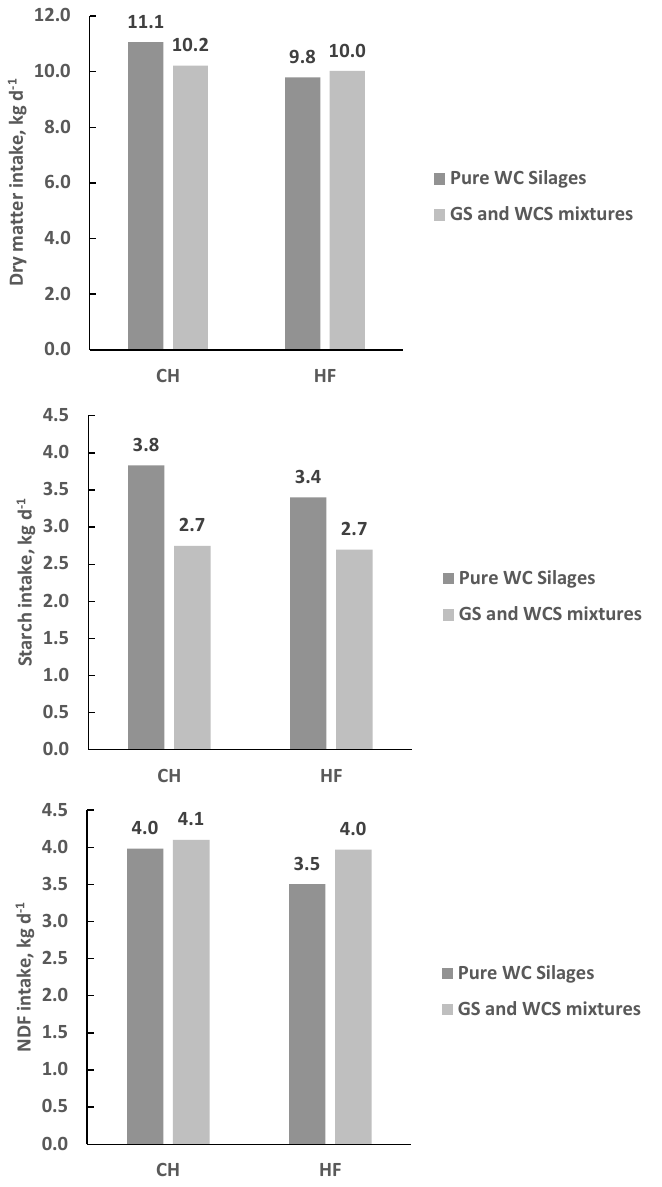
Fig. 1. Differences between Charolais (CH) and Hereford (HF) in intake responses to the partial replacement of whole crop (WC) silages (WCS) (triticale or barley) with grass silage (GS) in total mixture rations (interaction p <0.05; breed × contrast 4). Dry matter intake; SEM = 0.22, starch intake; SEM = 0.06, and neutral detergent fibre (NDF) intake; SEM =